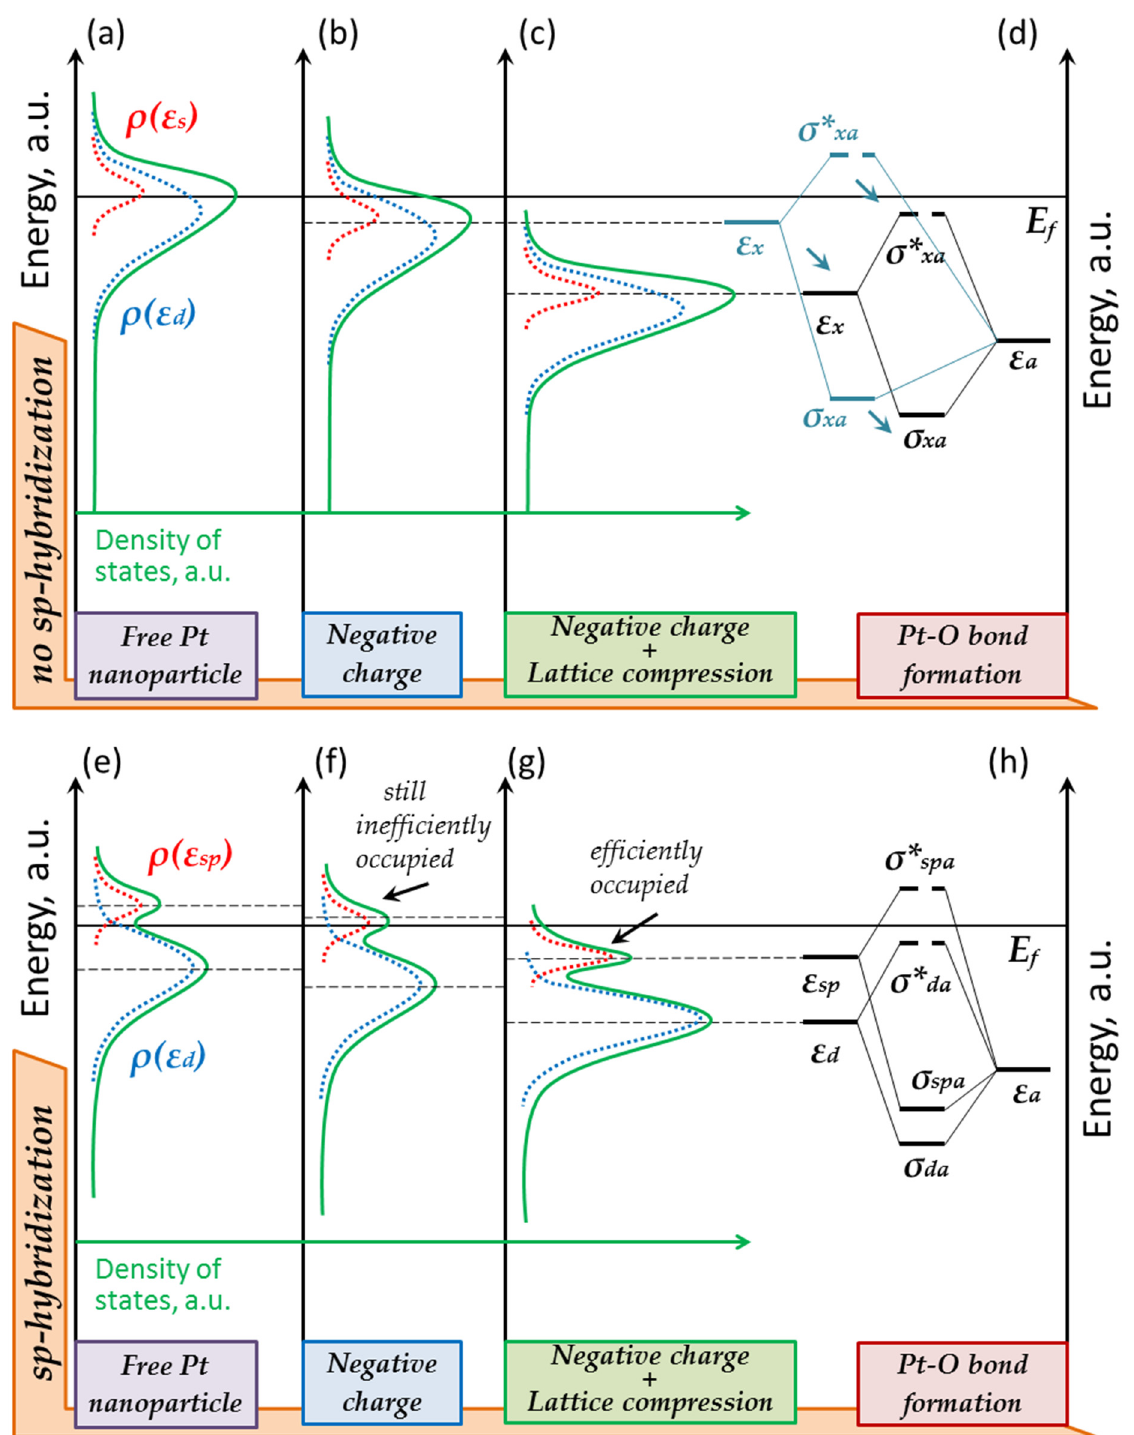
Figure 10. Adatom chemisorption on the surface of platinum nanoparticles without sp-hybridization ( a – d ) and with it ( e , f ). The influence of the charge and deformation factors is also shown: ( a , e ) unsupported platinum nanoparticle; ( b , f ) negatively charged platinum nanoparticle; ( c , g ) platinum nanoparticle with negative excessive charge and compressed atomic lattice; ( d , h ) formation of bonding and antibonding orbitals due to the interaction of adatom with surface states.